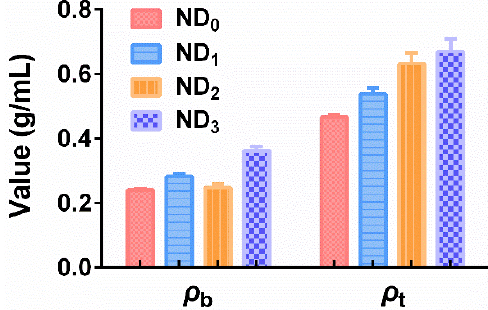
Figure 2. The bulk density and tap density of NTM DPIs ( n = 3).